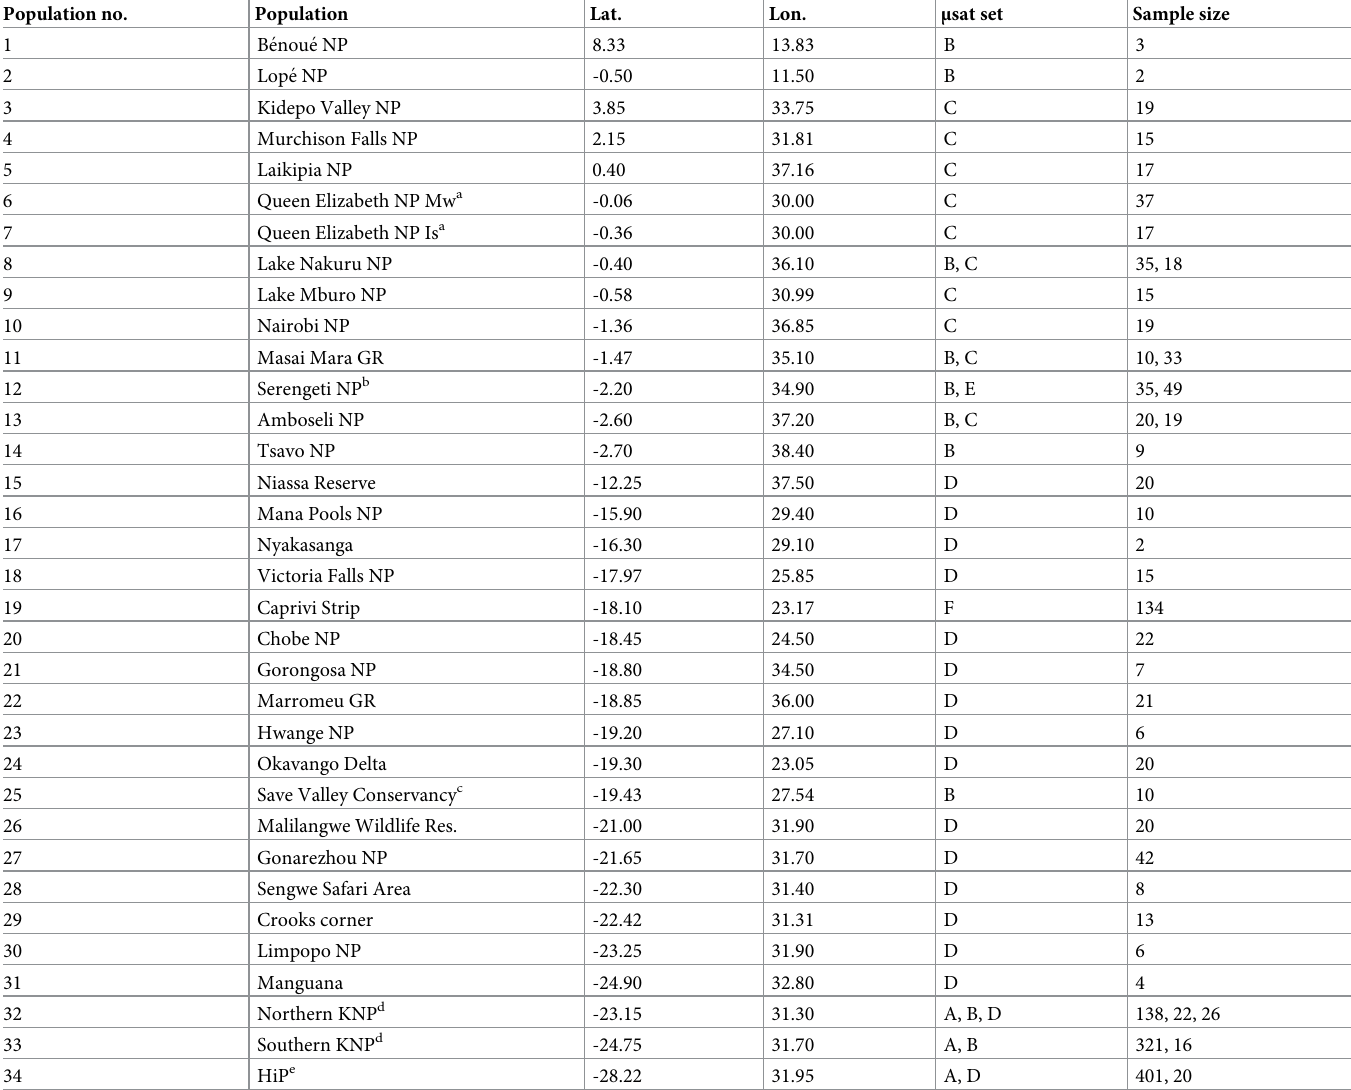
Table 1. Overview of African buffalo populations included in this study. Population